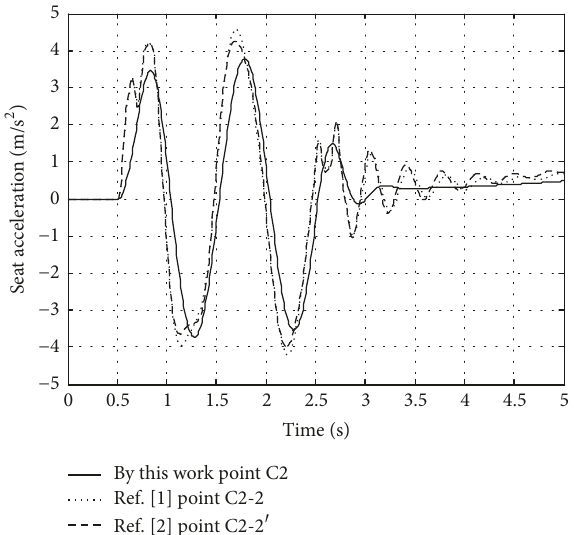
Figure 20: Time response of seat acceleration of design points C4, C4 4, and C4 4 󸀠